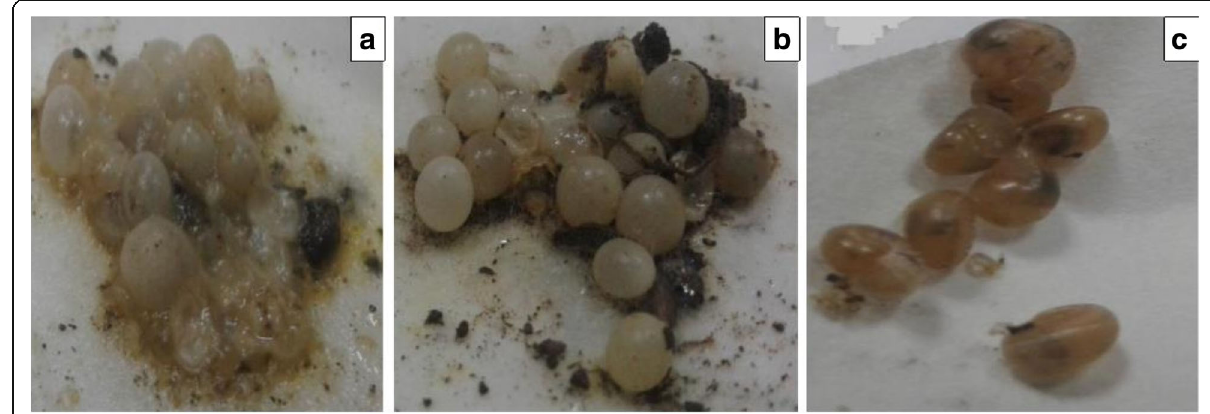
Fig. 3 Efficacy of imidacloprid ( a ) and fipronil ( b ) on hatchability of E . vermiculata compared with control ( c